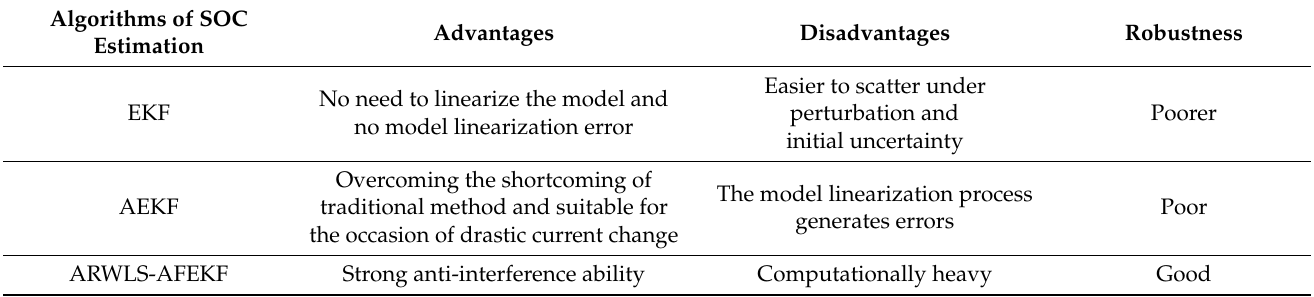
Table 3. Comparison of common SOC estimation